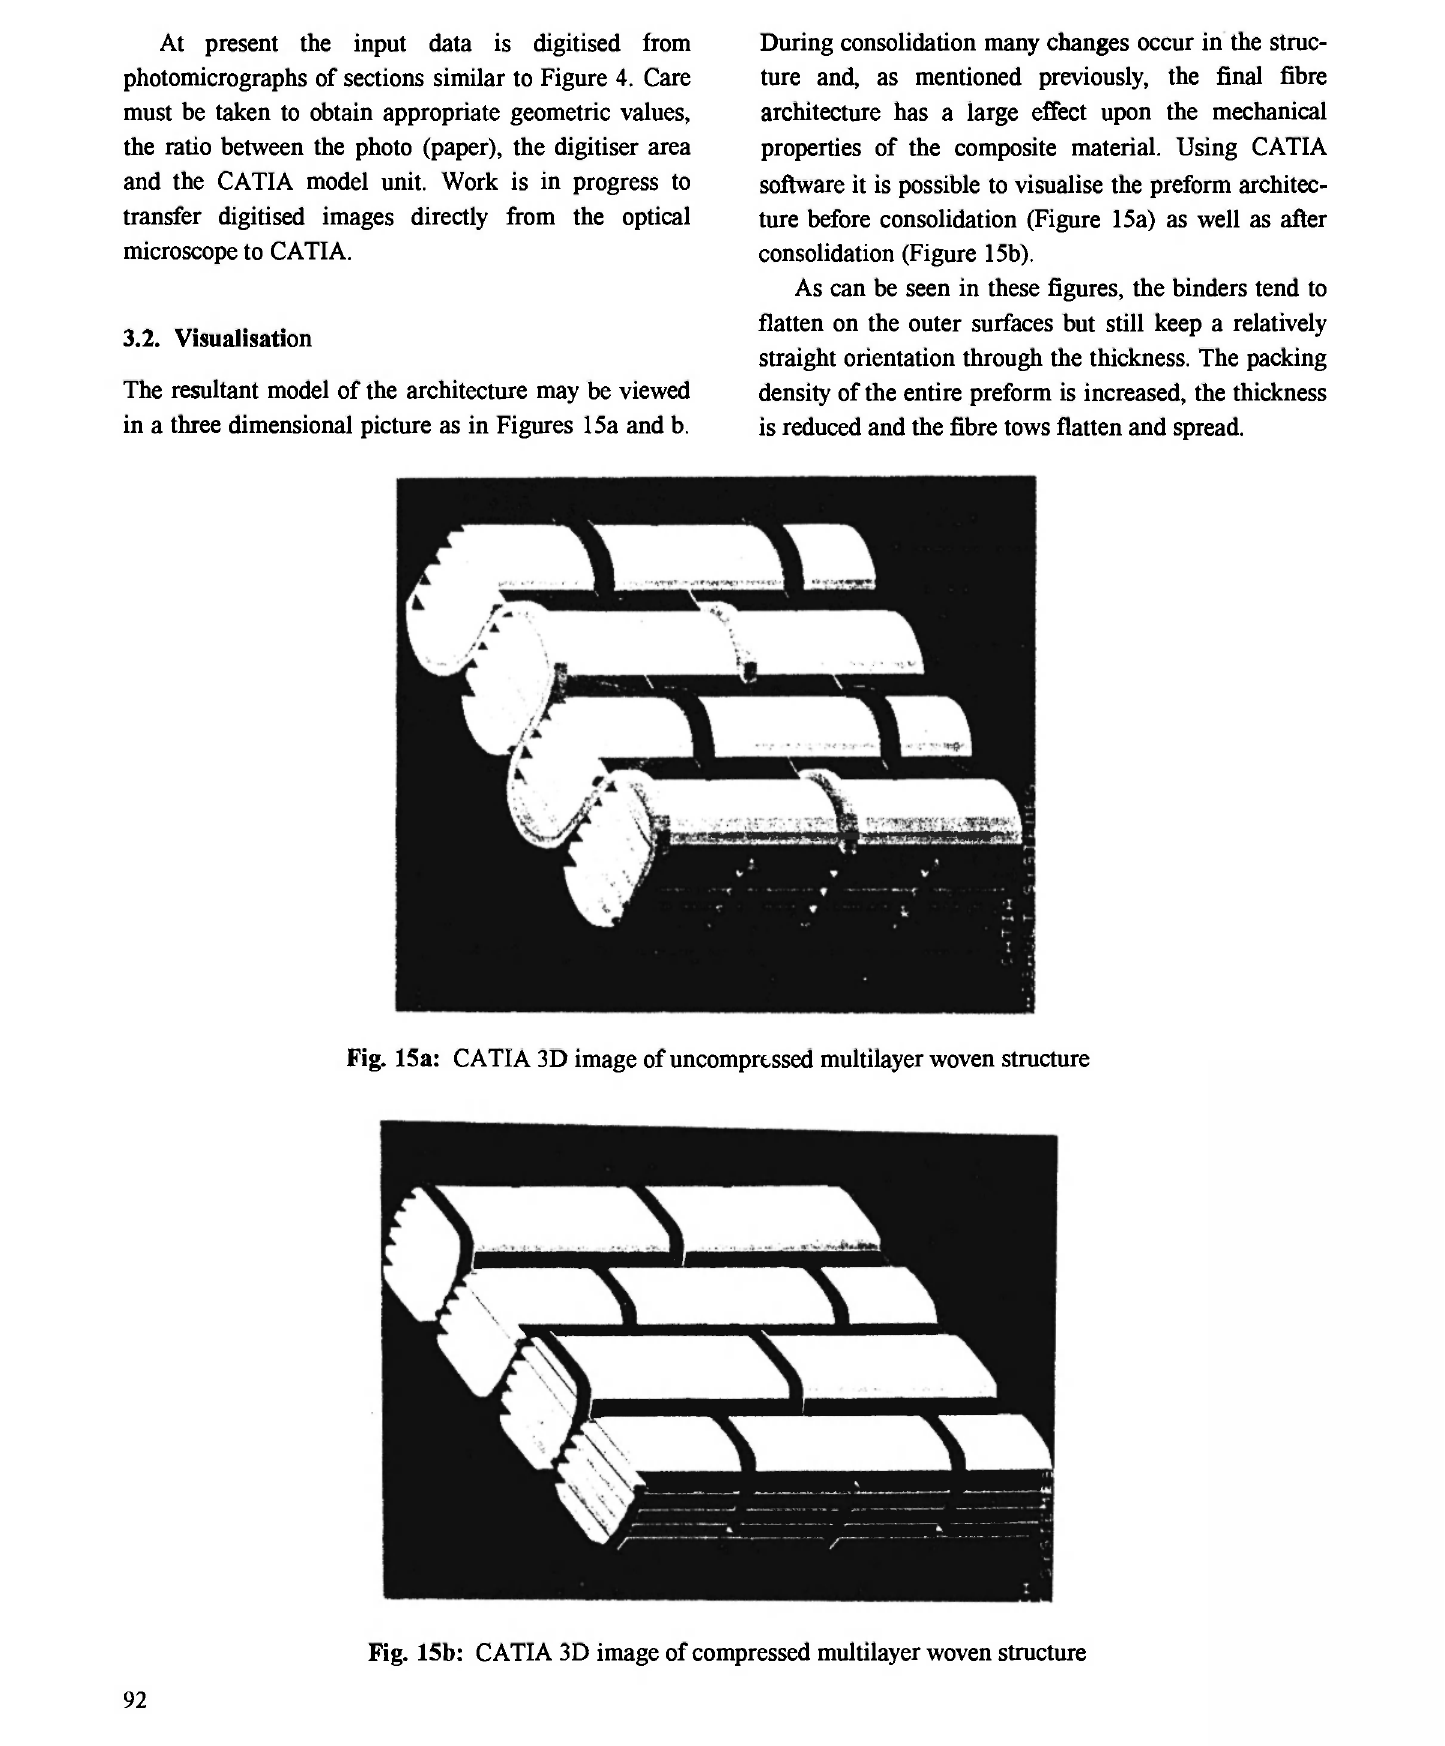
Fig. 15a: CATIA 3D image of uncompressed multilayer woven structure